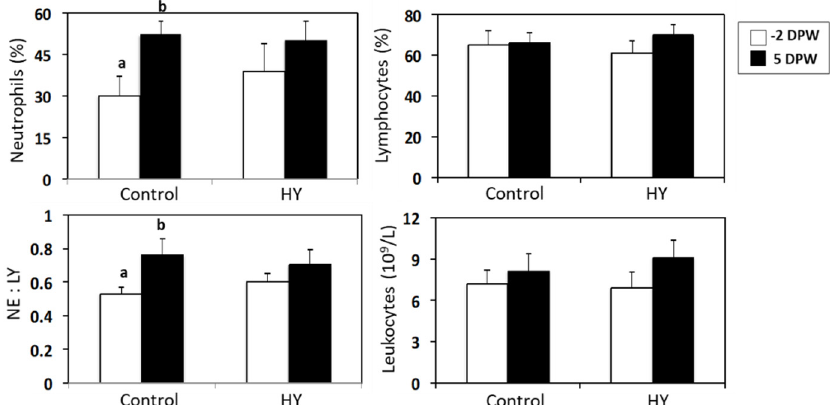
Figure 5. Changes in the composition and numbers of leukocytes in the calves fed di ff erent calf starters after weaning. Control represents calves fed calf starter without HY. HY represents calves fed calf starter with HY supplementation. Data are presented as the mean ± SE. Means with di ff erent letters di ff er significantly between − 2 and 5 DPW ( p < 0.05). NE, neutrophil; LY, lymphocyte; and DPW, days post-weaning.